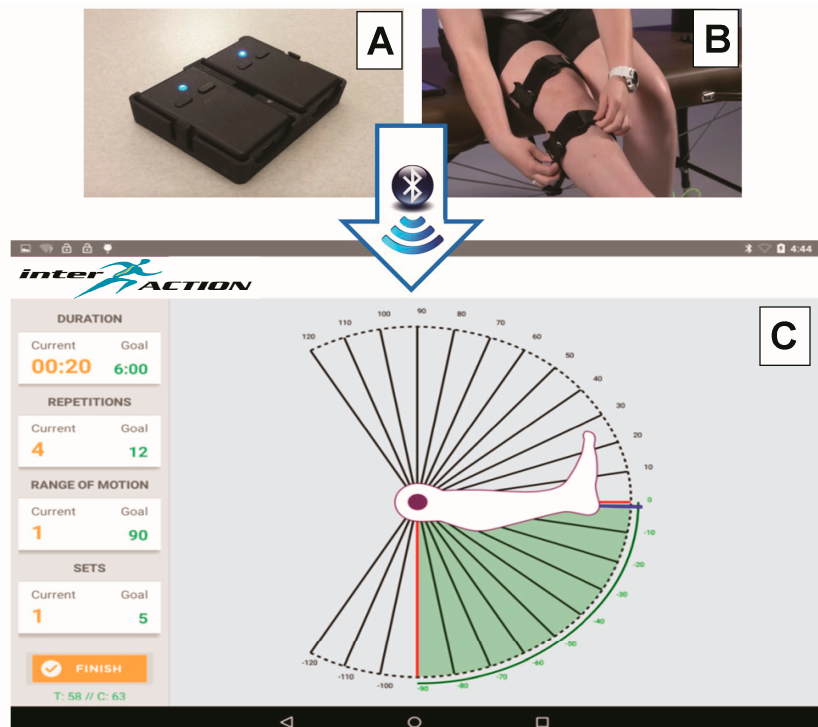
Figure 1. ( A ) Yost Lab’s two 3-Space Bluetooth sensors is a 3D printed case designed to align the sensors during alignment, ( B ) Padded elastic straps secured on the thigh and shank, Cary, ( C ) Screenshot of the mobile application screen that provides the participant with visual feedback.